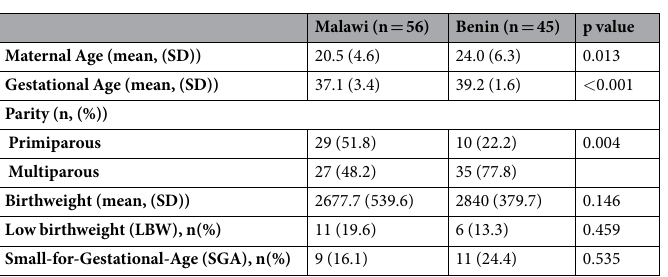
Table 1. Demographic and clinical characteristics of the analytic